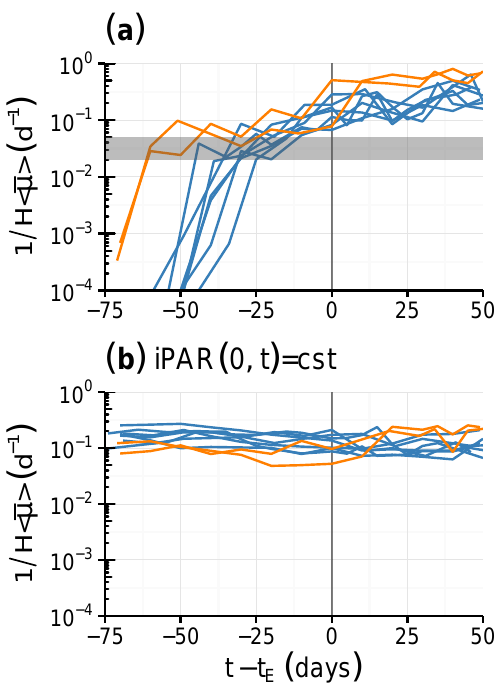
Figure 6. Time series of the daily mixed layer-averaged phyto- (cid:16) 1 (cid:17) (cid:104) ¯ µ (cid:105) plankton division rate based on Eq. (15) for the nine events H observed by the floats. All time series are shifted relative to t E . The blue lines represent the cases where the first accumulation of biomass was detected when the sea surface heat fluxes were still negative. The orange lines represent the cases where the first ac- cumulation of biomass was detected when the wintertime cooling shut down. The horizontal gray shading represents the winter phy- toplankton loss rates range, namely 0.02–0.05d − 1 . (a) Estimates based on a clear sky model of incoming irradiance for the days and latitudes sampled by each float (Gregg and Carder, 1990). (b) Esti- mates based on the periodic repetition of the daily cycle of incoming surface insolation on 1 March at 70 ◦